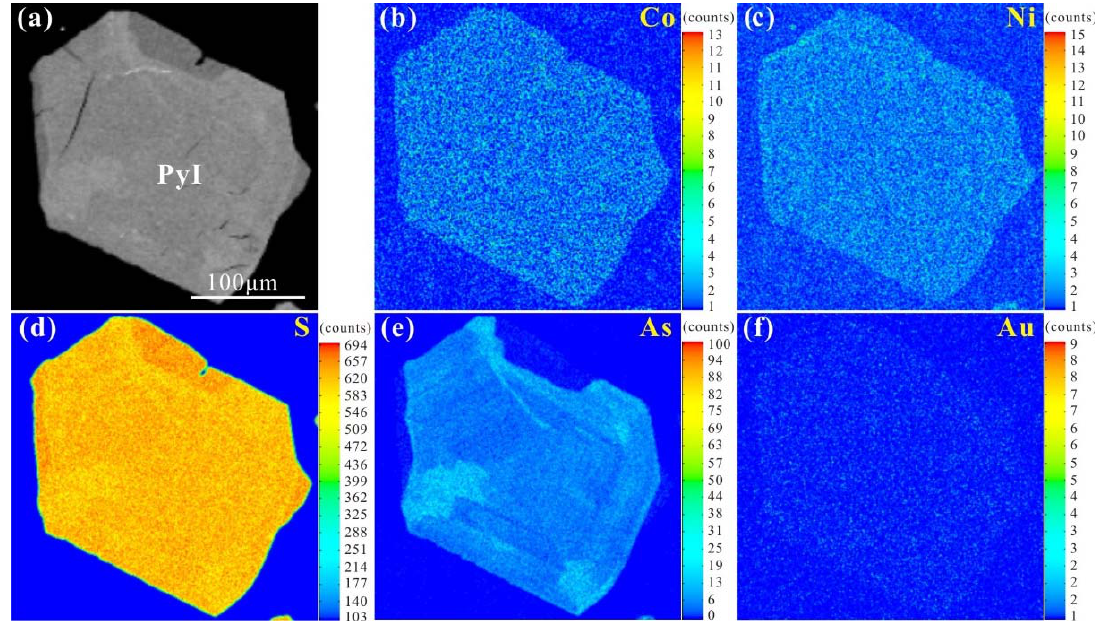
Figure 7. ( a ) Backscattered electron image of PyI from sample 330-9. ( b – f ) X-ray element distribution maps of Co, Ni, S, As, and Au in PyI. Cobalt and nickel show uniform distribution, but irregular arsenic enrichment occurs in isolated crystal PyI.